Question: Condense the content of this figure into a single sentence.
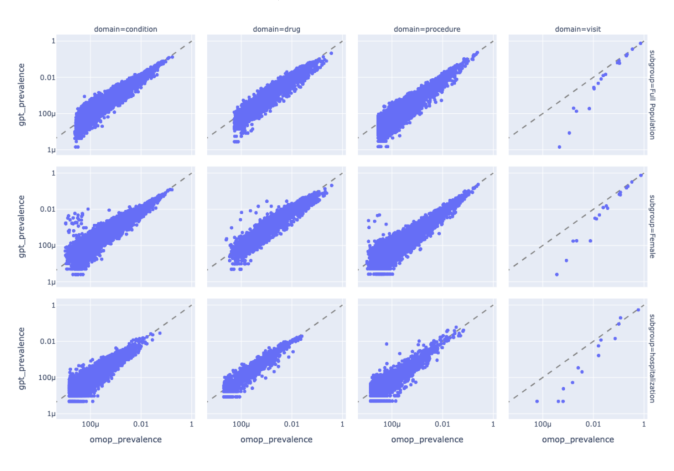
Answer: Concept prevalence comparison between the source OMOP and generated OMOP using top p = 95% in the log scale stratified by domain in columns and by population in rows, where x-axis and y-axis represent the source and the synthetic data re- spectively, and each dot represents a concept